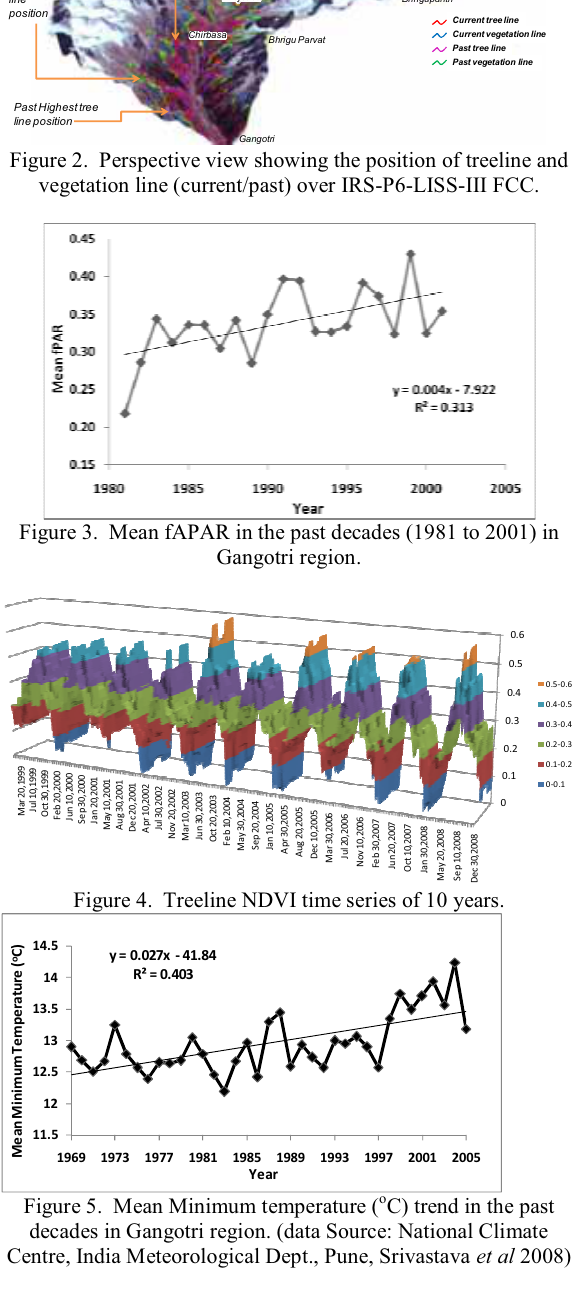
Figure 6. Scaled NDVI values for 10 years (1999 – 2008) from SPOT-VGT over treeline (Mean Altitude 3282m) in Gangotri. Time is in 10 day steps. [NDVI = scaled value *0.004)-0.1]